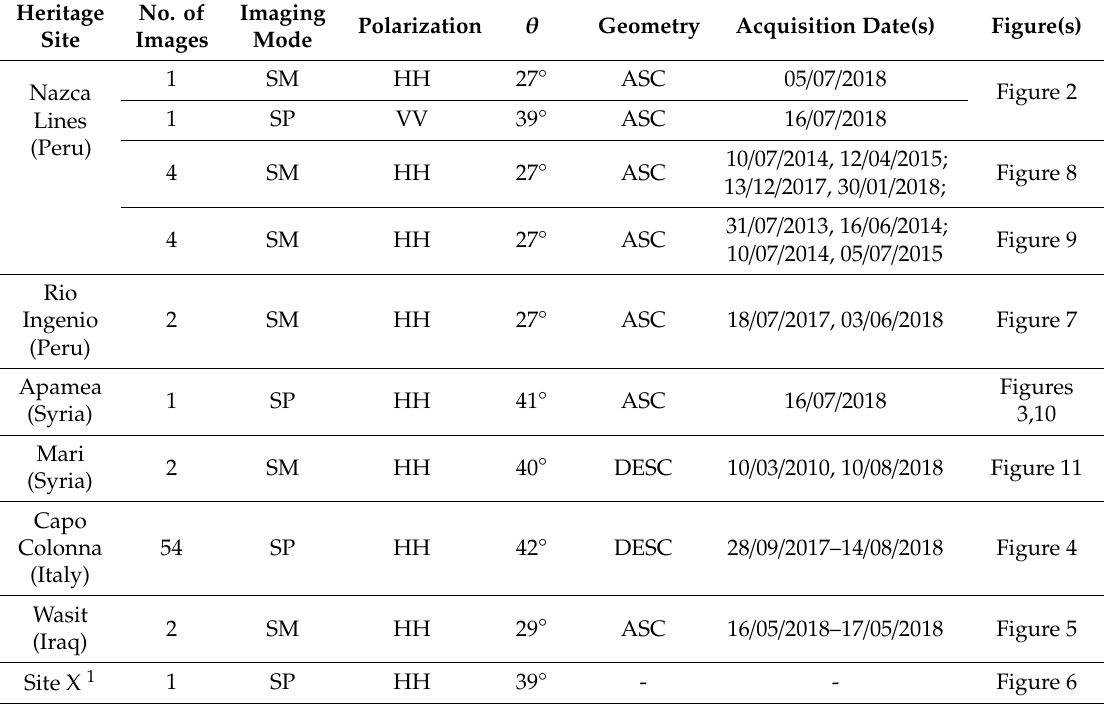
Summary of COSMO-SkyMed data used to develop the use-cases discussed in this